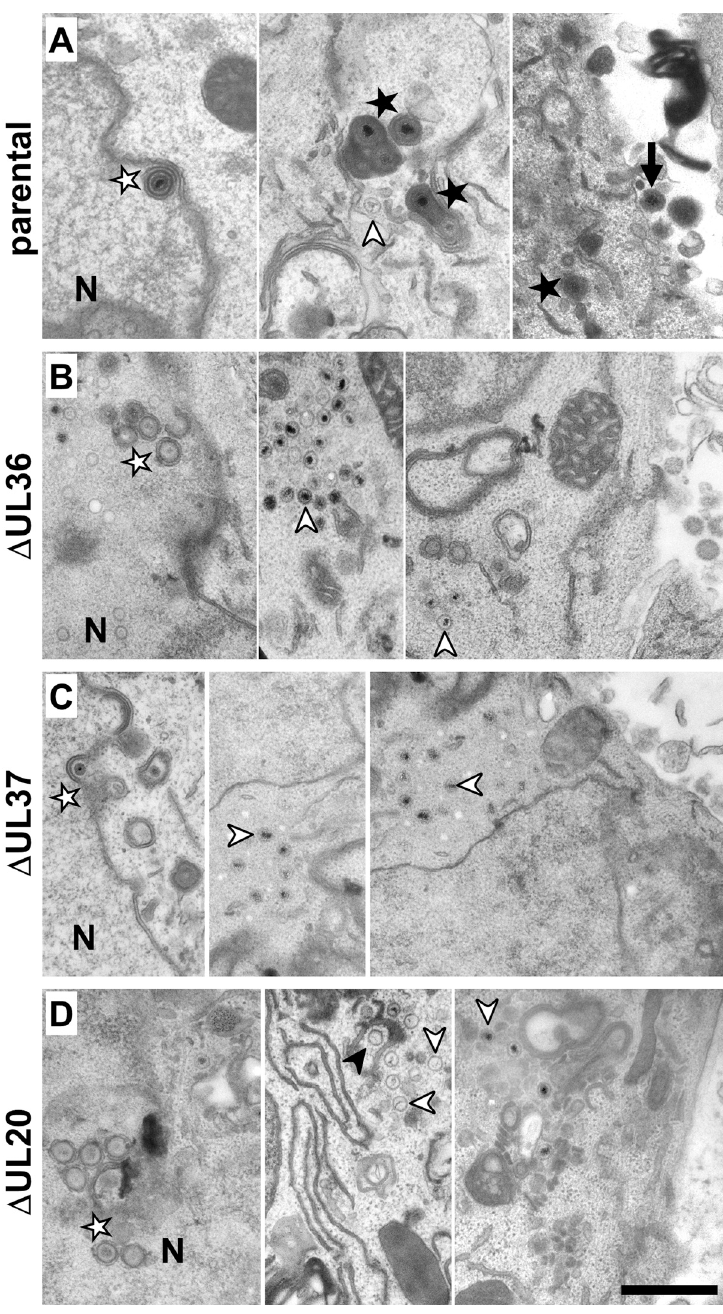
Fig 2. Cytosolic capsids accumulate in the absence of pUL36 or pUL37 and pUL20 is required for secondary envelopment in neurons. DRG neuronsinfected with 1 x 10 7 pfu/mL of HSV1(17 + )Lox- CheVP26 (A), - Δ UL36(B), - Δ UL37(C), - Δ UL20(D), fixed at 24 or 30 hpi and processedfor conventional electronmicroscopy.Nucleus (N), primary envelopedvirions (white stars), cytosolic capsids (white arrowheads), wrapping intermediateswith capsids beingclosely associatedwith cytoplasmicmembranes (black arrowheads), virions after completesecondary envelopment (black star), and extracellularvirions (arrow). Scale bar is 500